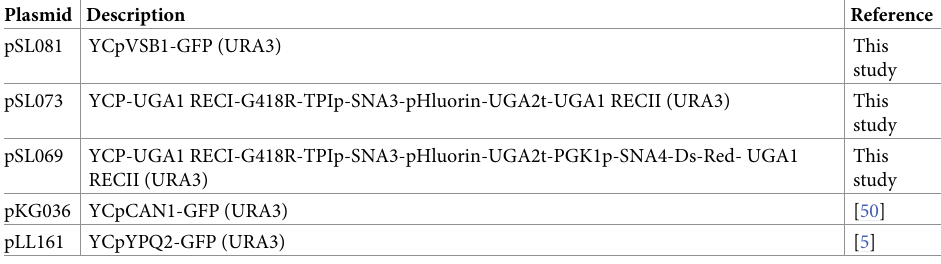
Table 3. Plasmids used in this study.